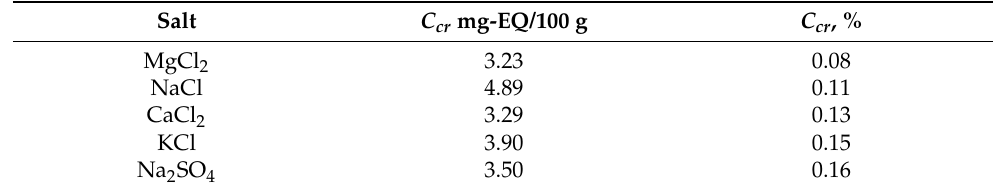
Table 3. Critical salt concentration ( C cr ) required for dissociation of pore gas hydrates in frozen sand interacting with MgCl 2 , NaCl, CaCl 2 , KCl, and NaSO 4 solutions at − 6.5 ◦ C and 0.1